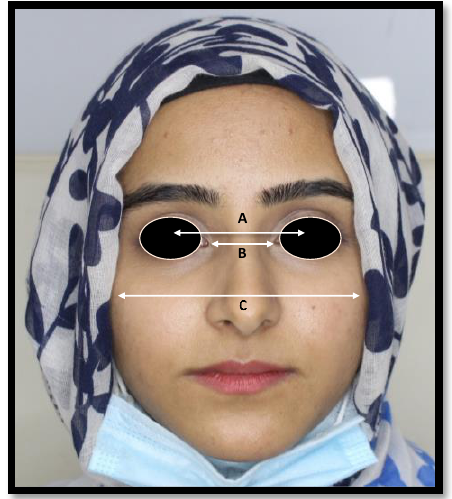
Figure 3. The mid horizontal facial third measurements (A) IPD (Interpupillary distance) (B) ICD (Inner canthal distance), (C) BZD (Bizygomatic distance).